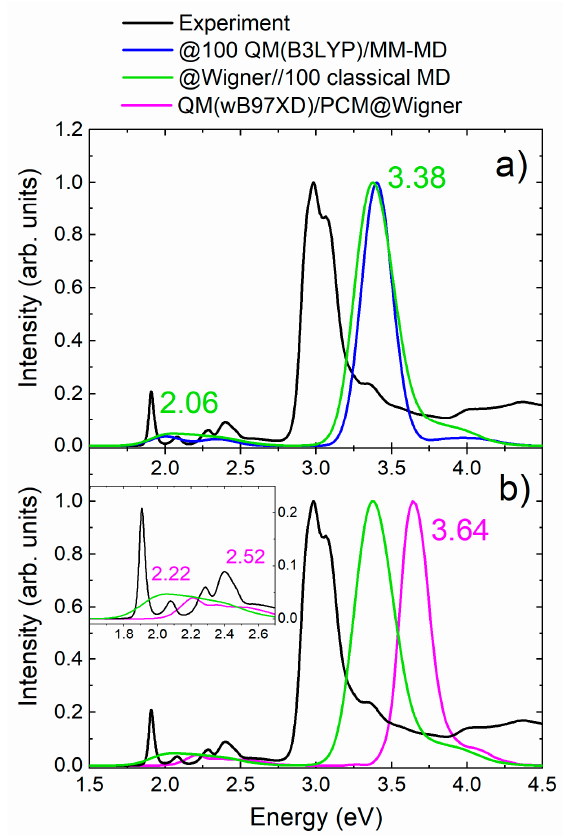
Figure 3. ( a ) Comparison of the hybrid-Wigner-MD spectrum and its energies at the maxima (green) with the @100 QM(B3LYP)/MM-MD (blue) and with the experimental absorption spectrum of mTHPC in methanol (black). ( b ) Comparison between QM(wB97XD)/PCM@Wigner (pink) and QM(wB97XD)/MM@hybrid-Wigner-MD (green) absorption spectra with respect to the experimental absorption spectrum of mTHPC (black) scaled with respect to the Soret band. The inset zooms the Q’ and Q ′′ bands.